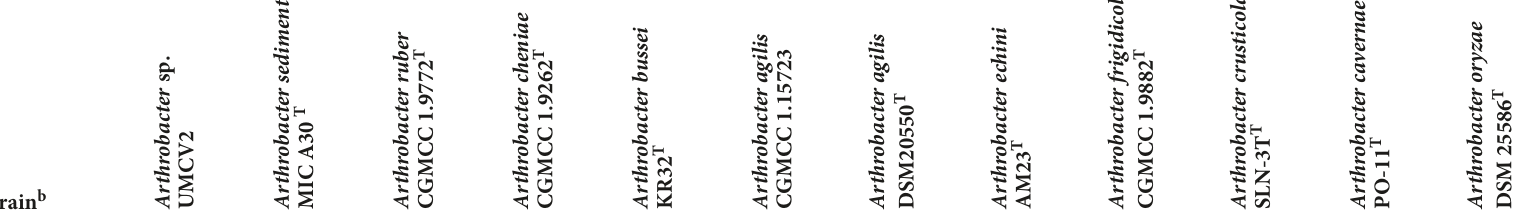
Bacterial strain